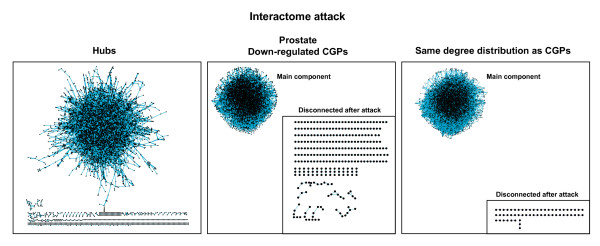
CGPs attack and interactome network structure integrity. Interactome network examples after removing an equivalent number of hubs, prostate down-regulated CGPs (data set 1 [14]) or selected proteins with the same degree distribution as CGPs, but with lower values of betweenness and closeness. Disconnected nodes from the main component are shown in inset to emphasize the difference between CGPs and selected proteins.